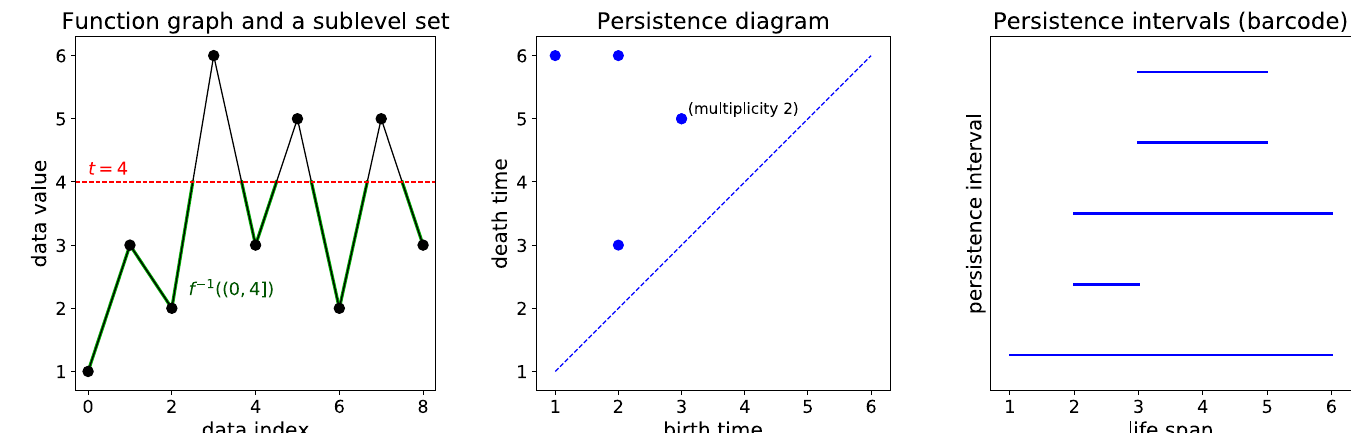
Fig 1. Persistent homology example. (a) Time series data ( r 0 , ... , r 8 ), the continuous function f obtained by linear interpolation, and the sublevel set f − 1 ((0, 4]); note the four connected components that are ‘alive’ at this time. (b) The corresponding persistence diagram containing five birth-death points; note the repetition of (3,5): both occurrences of this point correspond to connected components that are born, respectively, at indices 4 and 8. (c) The persistence intervals for all the birth-death pairs.